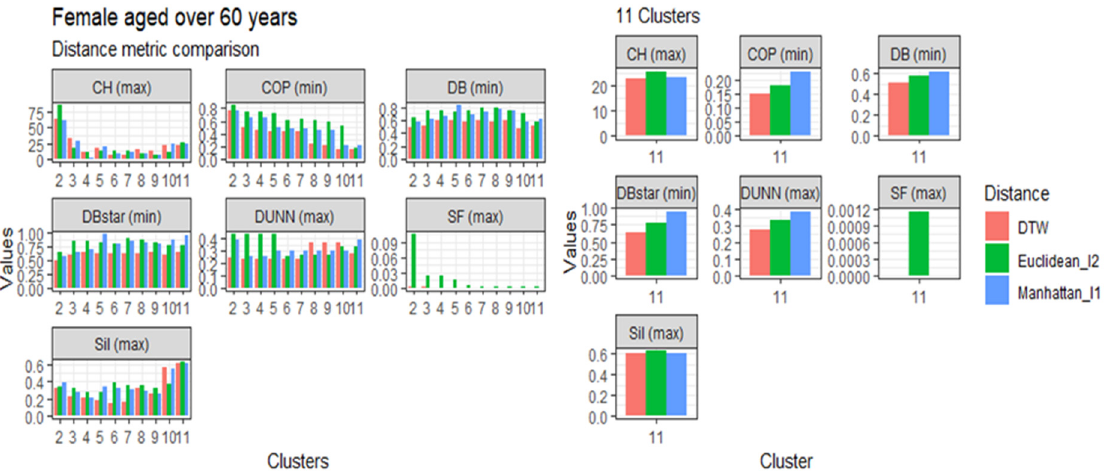
Figure 3. Model comparison of the DTW, Euclidean (l1), and Manhattan (l2) distance criteria for females aged 20 to 60.